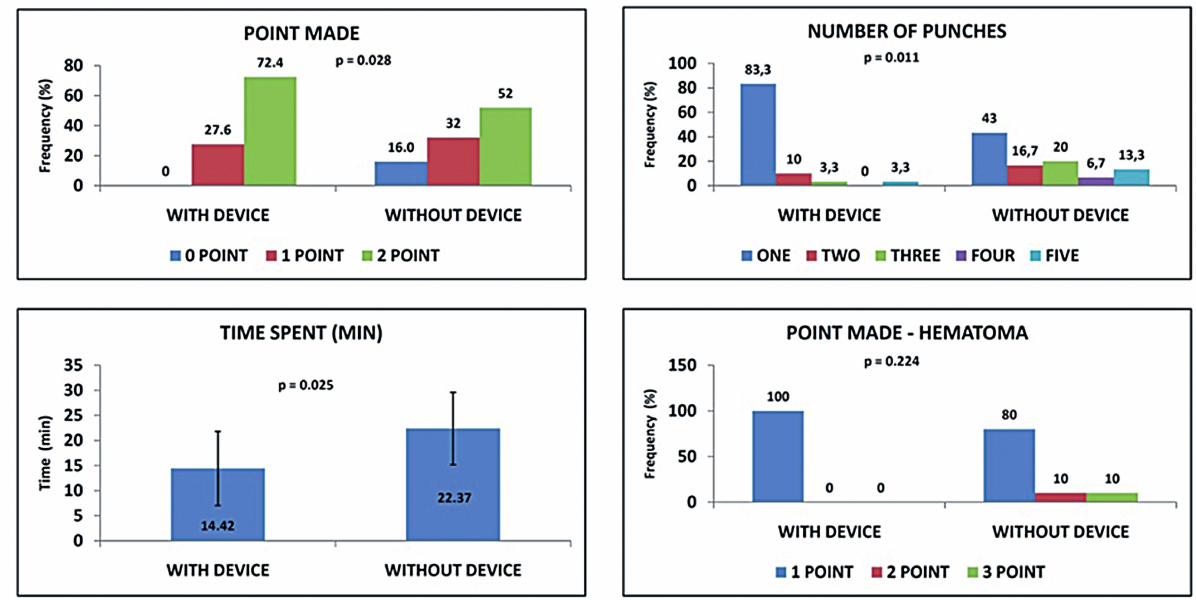
Figure 3 - Comparison of frequencies and means between the Punctiometer and no Punctiometer groups: A) Precision index; B) number of puncture attempts required; C) mean time required to perform three punctures in each kidney; D) grade of complications (which were all